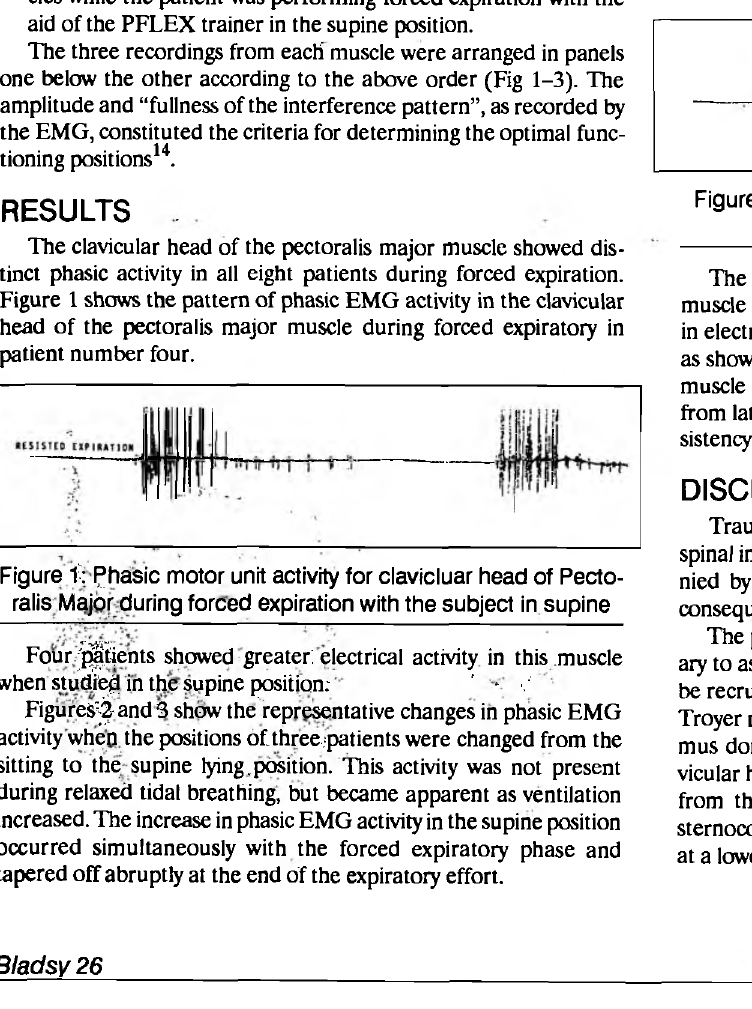
Figure 3: Phasic motor unit activity in calvicular part of Pectoralis Major during forced resisted expiration with the subject in sitting and in lying